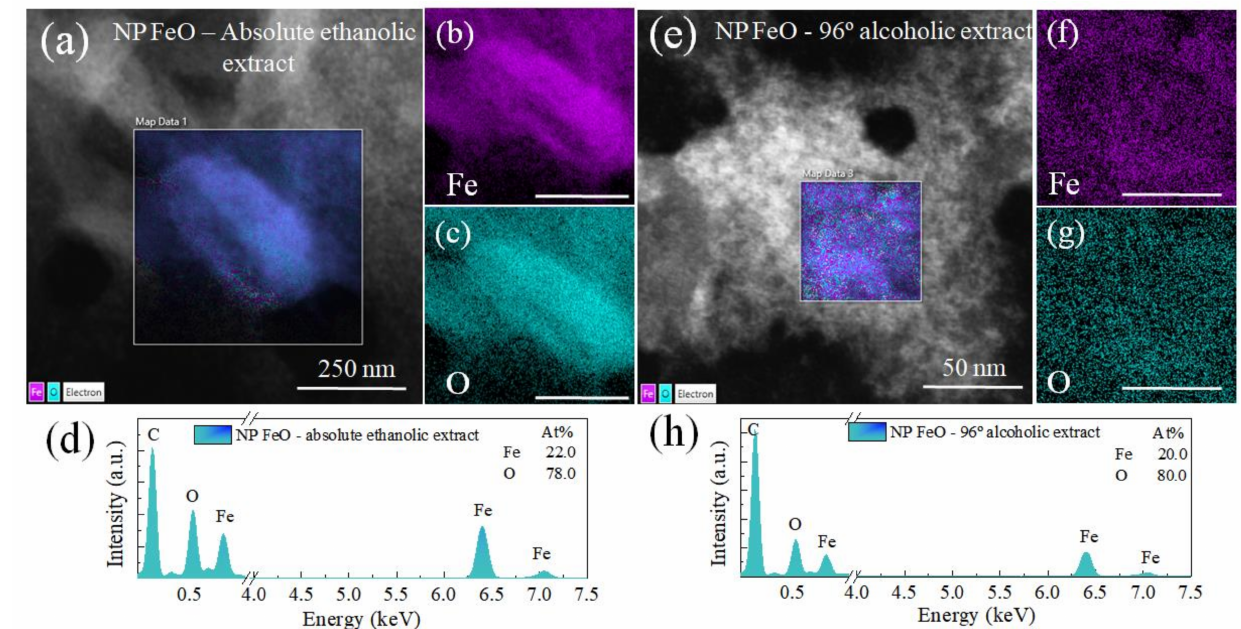
Figure 6. Result of characterization by EDX of FeO NPs mediated by green synthesis using extract in ( a – d ) the absolute ethanol solvent, and ( e – h ) the 96% alcohol